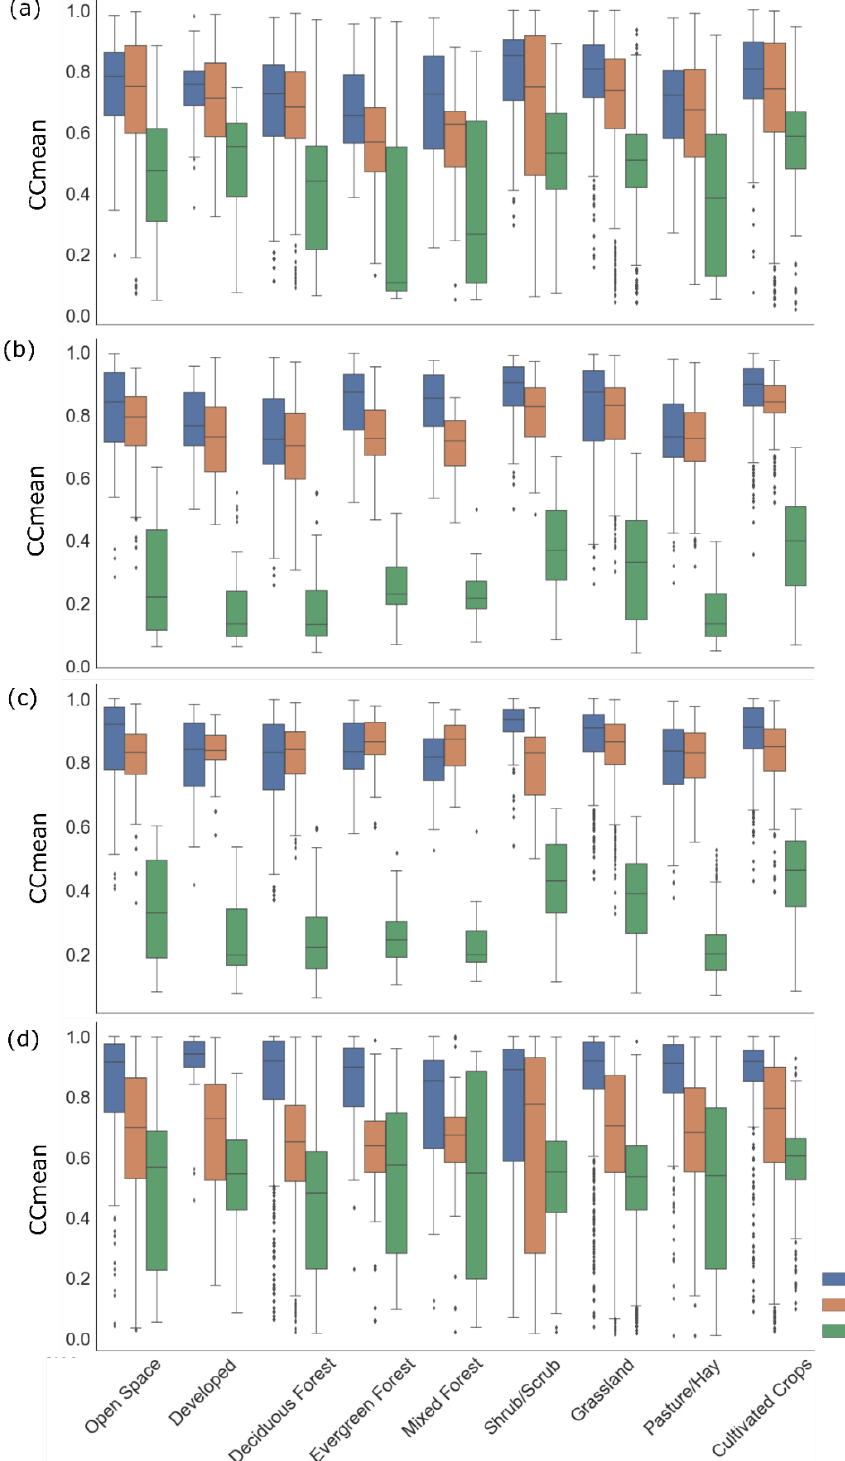
Figure 10. Mean correlation coefficient (CC mean ) between each soil moisture product and the TC- derived “unknown truth” at local 6 a.m., for nine Oklahoma state representative land cover types (see Table 3). Results are discretized by season: ( a ) spring, ( b ) summer, ( c ) fall, and ( d ) winter for the period from April 2015 to July 2019.